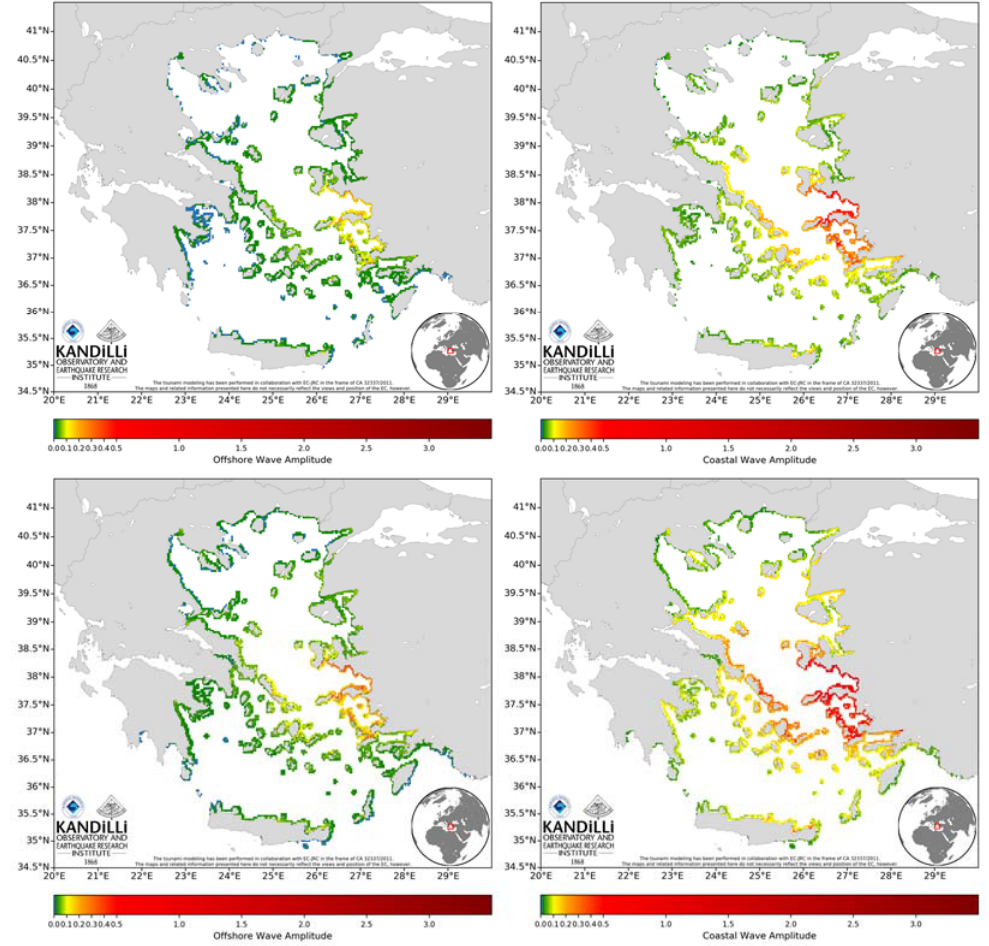
Figure 10. A comparison of offshore (actual value calculated in the last “wet” cell in tsunami modeling) ( left ) and coastal (projection of the offshore wave amplitude to the coast line through Green’s law approximation) ( right ) wave amplitudes derived from MOD2–TR tsunami scenario database [20,21] for the 30 October 2020 Samos earthquake, with Mw 6.9 ( top ) and Mw 7.0 ( bottom ) being the final initial Mw values, respectively, used by KOERI in the tsunami warning message.